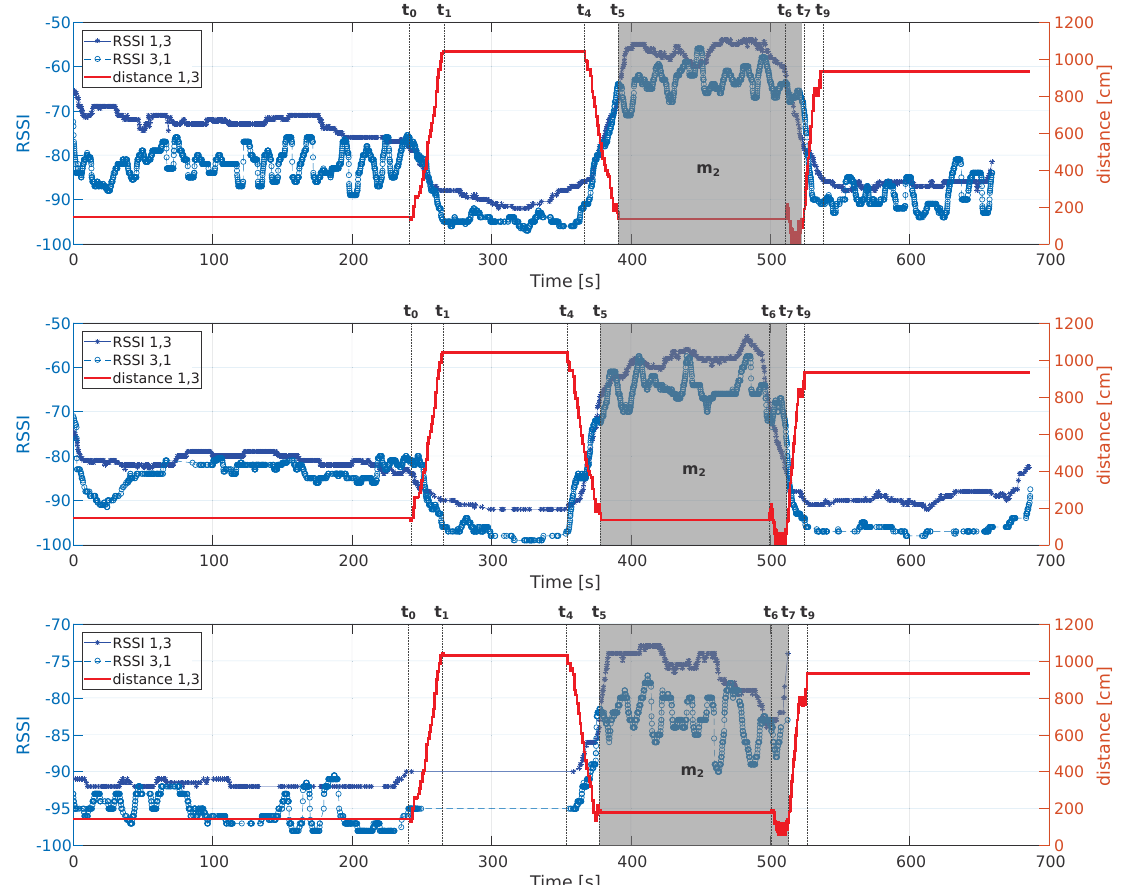
Figure 7. Symmetry analysis between Mobile 1 and Mobile 3 in accordance with the relative distance. Relevant timestamps related to the movements of Actors 1 and 3 in the scenario “Social 4” are shown, together with the social interaction period Meeting m2 as grey area. From the top to bottom, the transmission power values are: 3 dBm ( top ); − 6 dBm ( middle ); and − 18 dBm ( bottom